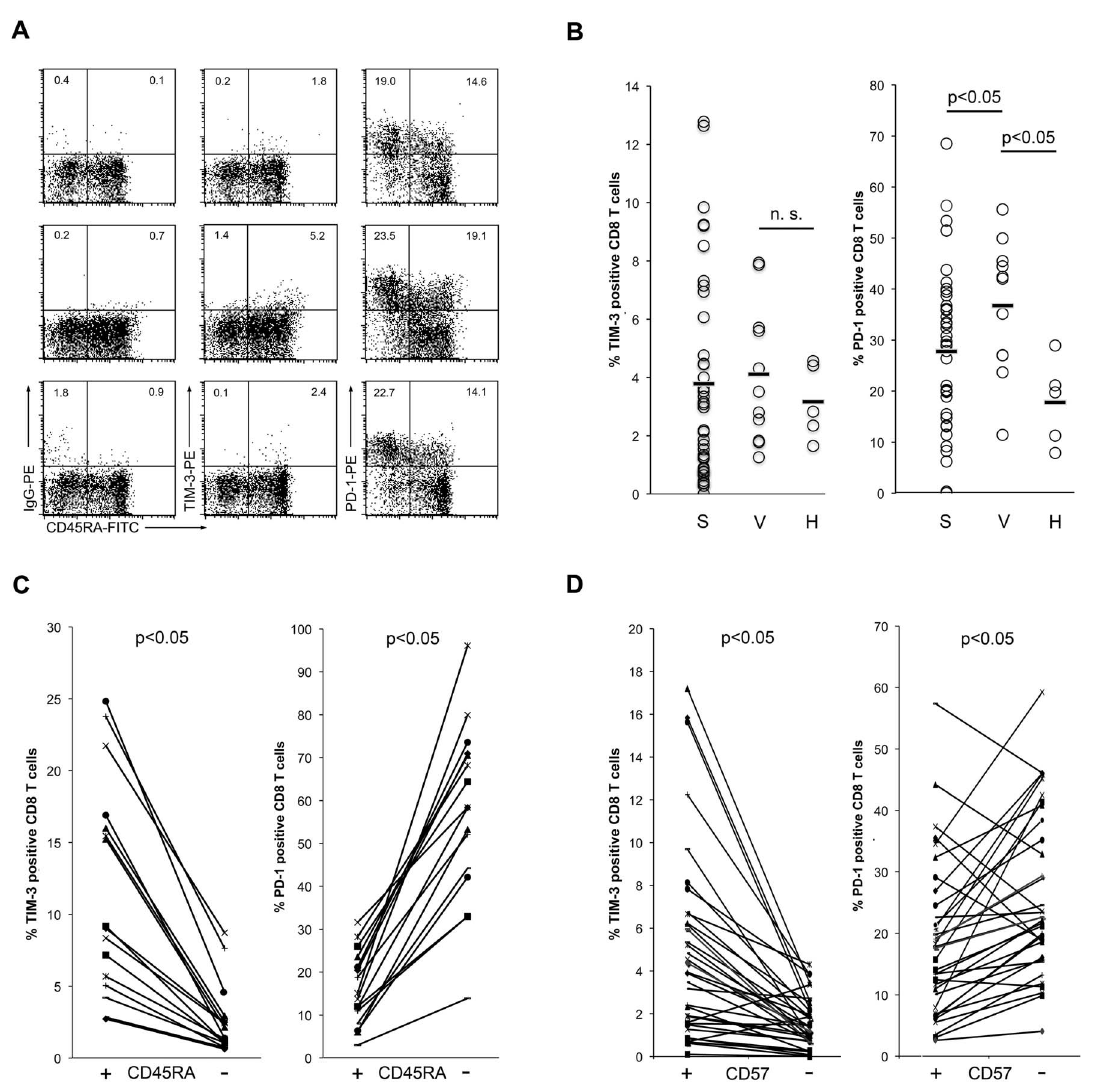
Figure 5. TIM-3 expression on CD8 T cells of HIV-1-infected individuals. A) TIM-3 and PD-1 expression on CD8 T cells from HIV-1-infected individuals. The percentage of positive cells in the CD45RA + and CD45RA 2 subsets are indicated. Correct assessment of TIM-3 and PD-1 positive cells was ensured by isotype control antibody (IgG-PE) staining for each sample. Representative samples from a suppressed (upper panels) and from viremic patients (middle and lower panels) are shown. B) Percentage of TIM-3 + (left graph) and PD-1 + (right graph) CD8 T cells from suppressed (S) and viremic (V) patients and from healthy individuals (H) are shown. Bars indicate median percentage. C) Percentage of TIM-3 + (left graph) and PD-1 + (right graph) CD8 cells in the CD45RA + and CD45RA 2 subsets. D) Percentage of TIM-3 + (left graph) and PD-1 + (right graph) CD8 cells in the CD57 + and CD57 2 subset.